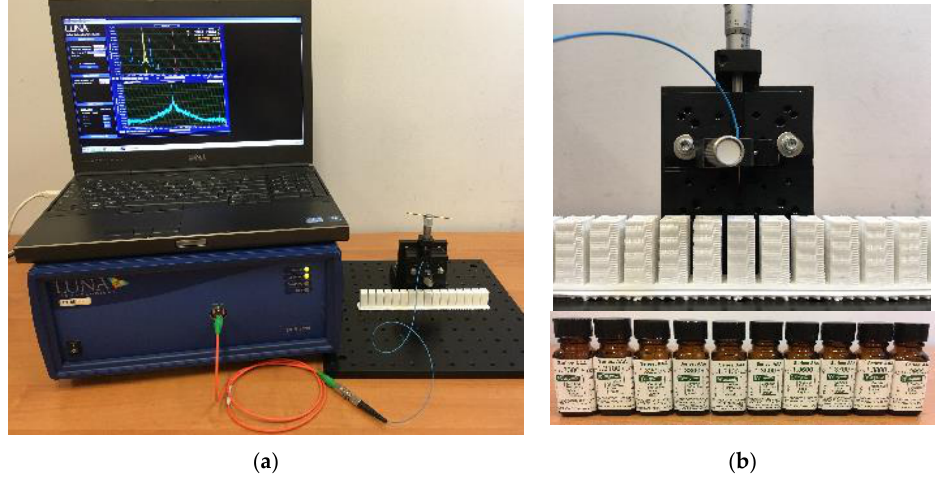
Figure 3. Experimental set-up for refractive index (RI) measurements by using the manufactured microtips—( a ) and a manual stage with a fiber holder and a set of cuvettes with calibration liquids— ( b ).